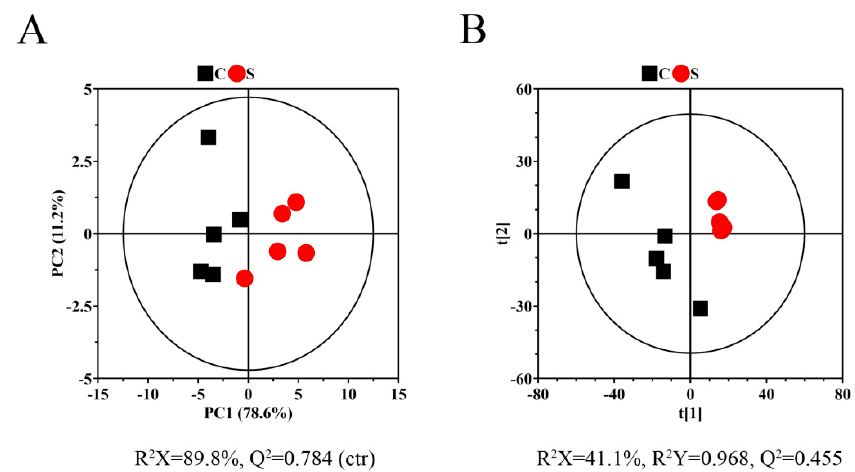
Figure 3. ( A ) 2D principal component analysis (PCA) scores plots based on 1 H NMR spectra of A549 cells obtained from groups C and S. ( B ) Partial least squares-discriminant analysis (PLS-DA) scores plots based on 1 H NMR spectra of A549 cells obtained from groups C and S. The experimental group of A549 cells (group S) were treated with 16 µ g / mL FIP-nha for 24 h, and the control group (group C) was treated with same volume of PBS for 24 h.